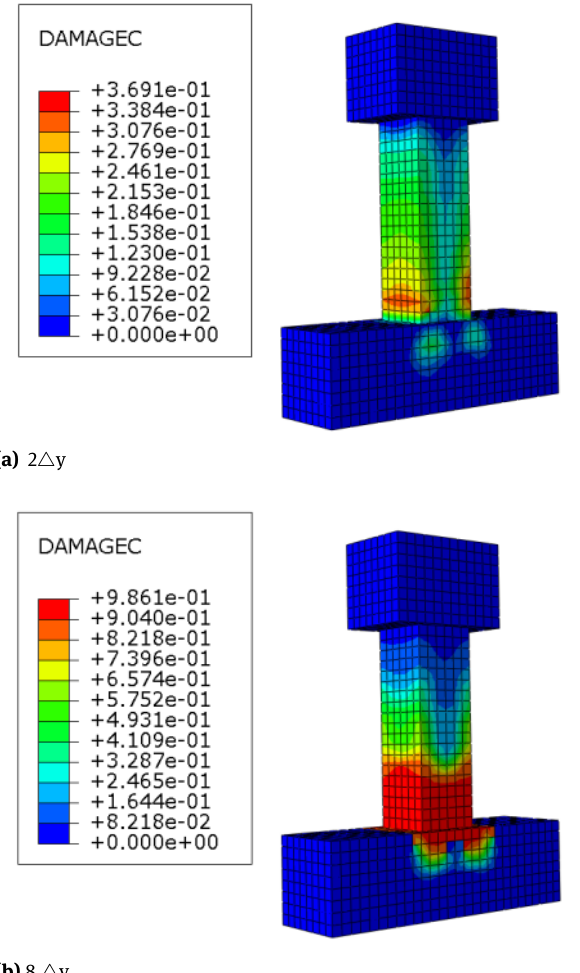
Figure 17: Nephograms of Compression Damage of C6